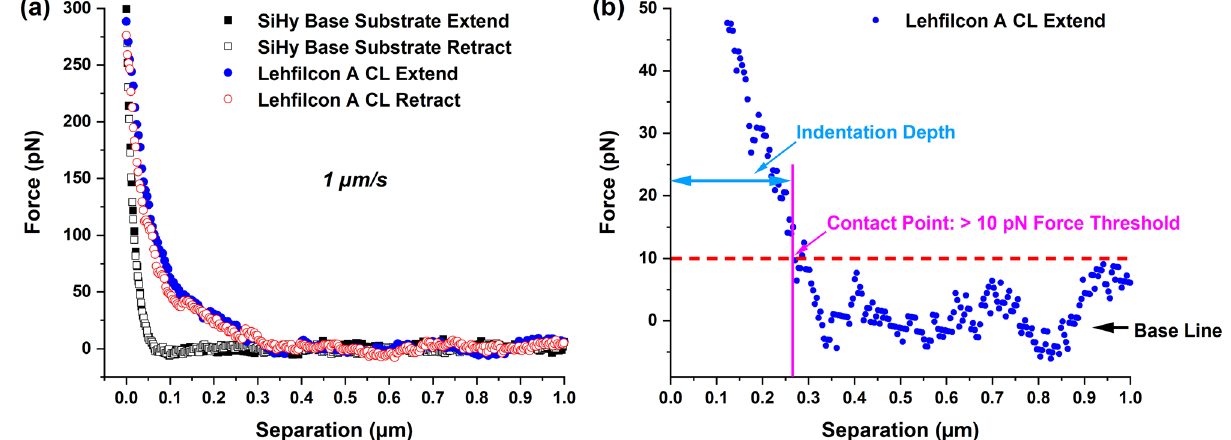
Figure 6. ( a ) AFM nanoindentation force-curves for lehfilcon A CL and SiHy base substrate; ( b ) force curve showing contact point estimation using the background noise threshold